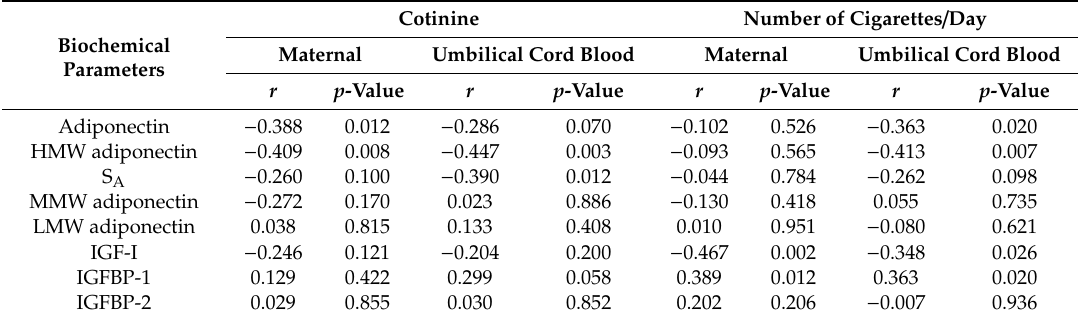
Table 2. Relationships between levels of studied biochemical parameters and cotinine as well as number of cigarettes /